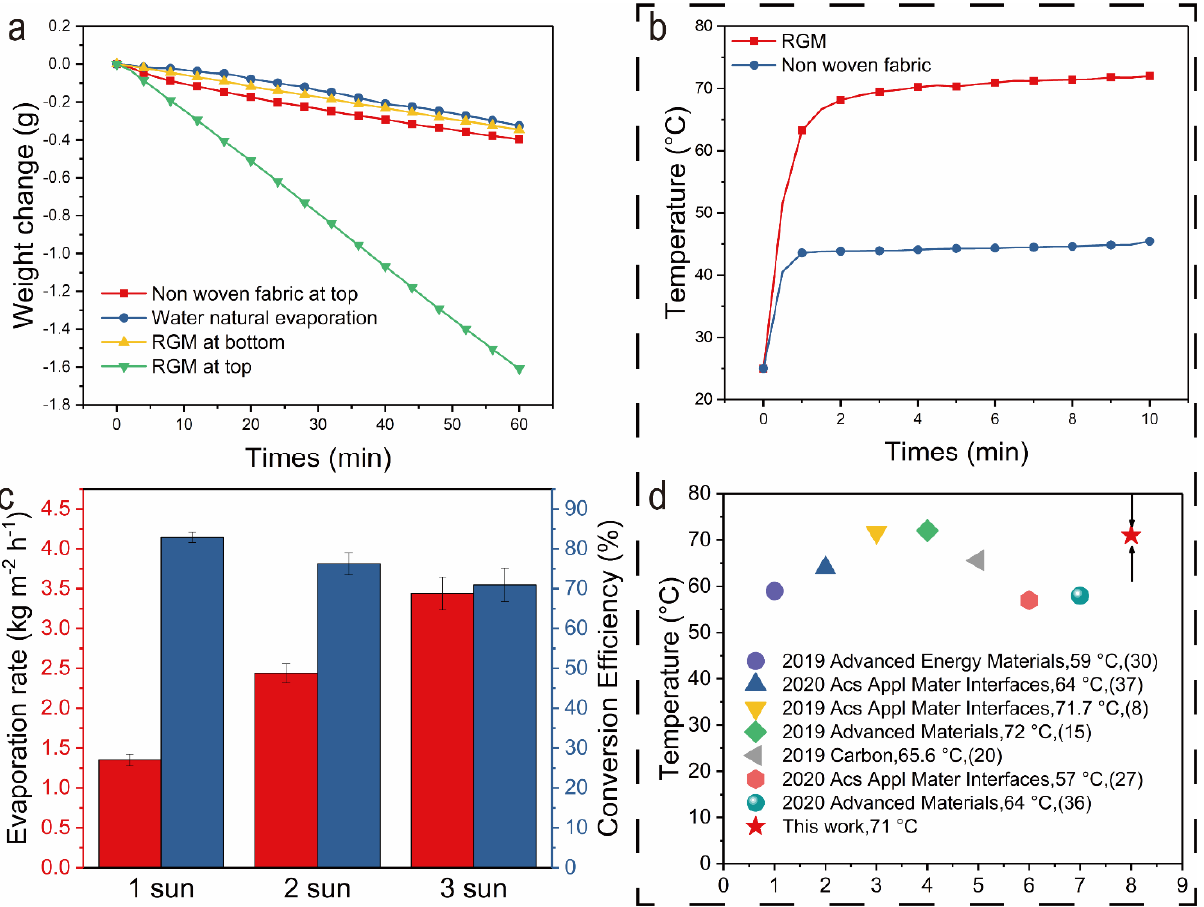
Figure 9. ( a ) Weight change diagram under four evaporation modes (natural evaporation of pure water, evaporation of non-woven fabric at the top, evaporation of RGM at the bottom and evapora- tion of RGM at the top). ( b ) Temperature rises curve of non-woven fabric and RGM under 1 sun condition. ( c ) Evaporation rate and photothermal conversion efficiency under different light inten- sities. ( d ) Comparison of heating efficiency in evaporator previously reported (reference numbers are in brackets).